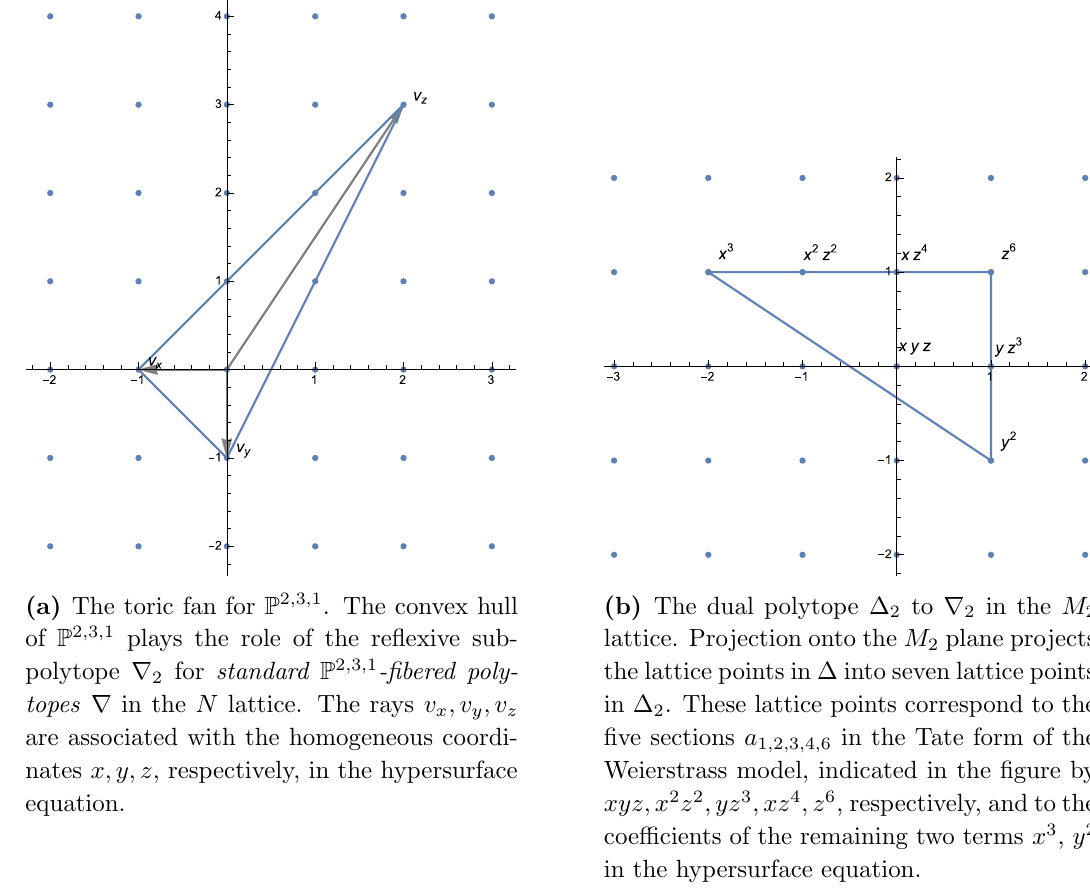
Figure 1. The re(cid:13)exive polytope pair for the P 2 ; 3 ; 1 ambient toric